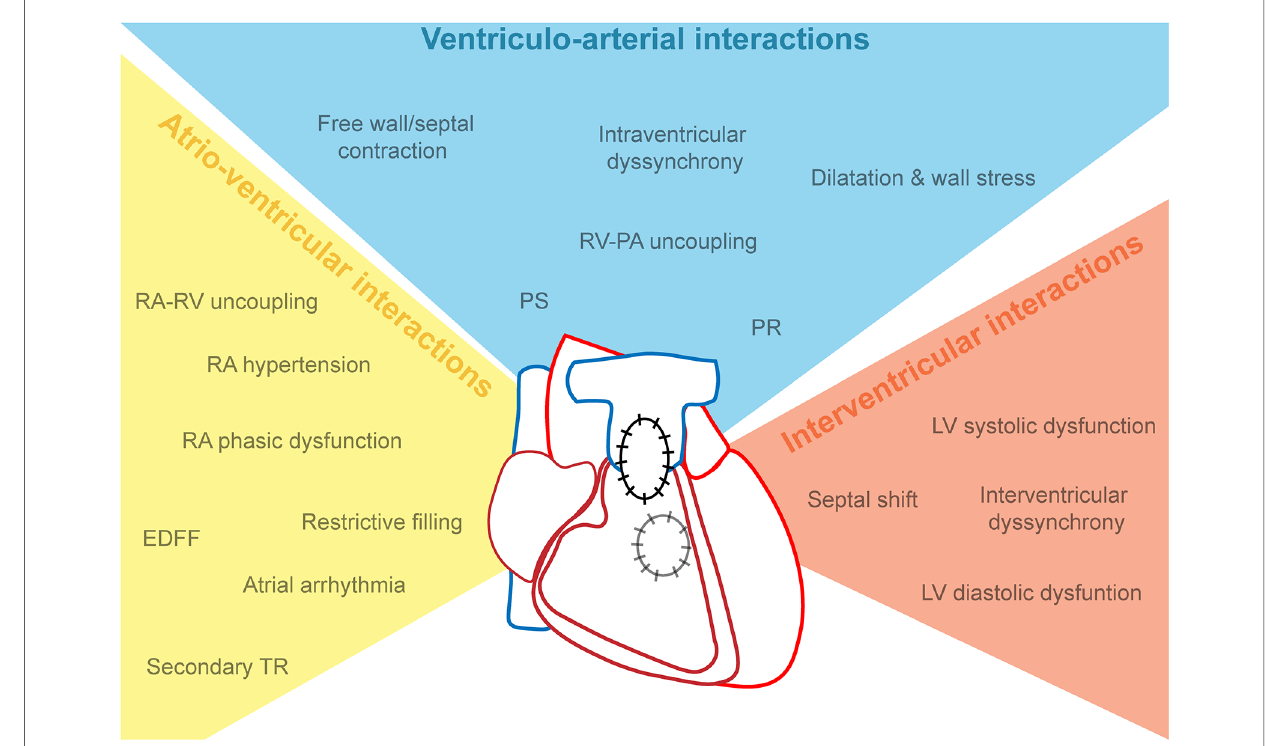
FIGURE 2 The syndrome of cardiac dysfunction in repaired tetralogy of Fallot, categorized as atrio-ventricular, ventriculo-arterial and interventricular interactions. EDFF, end-diastolic forward fl ow; LV, left ventricle; PA, pulmonary artery; PS, pulmonary stenosis; PR, pulmonary regurgitation; RA, right atrium; RV, right